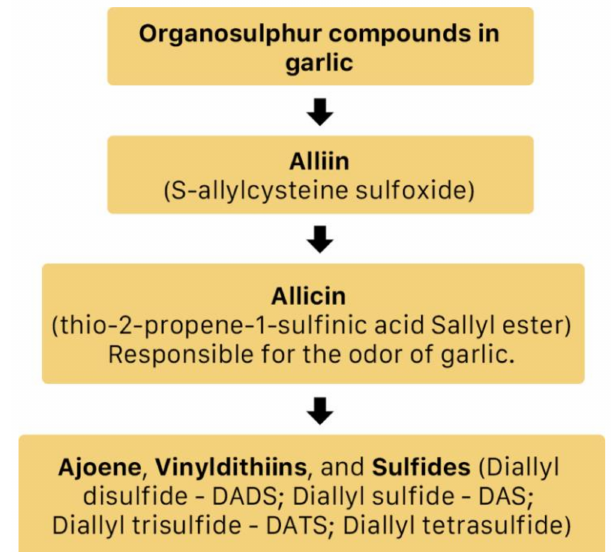
Figure 14. The conversion of organosulfur compounds in garlic [64].